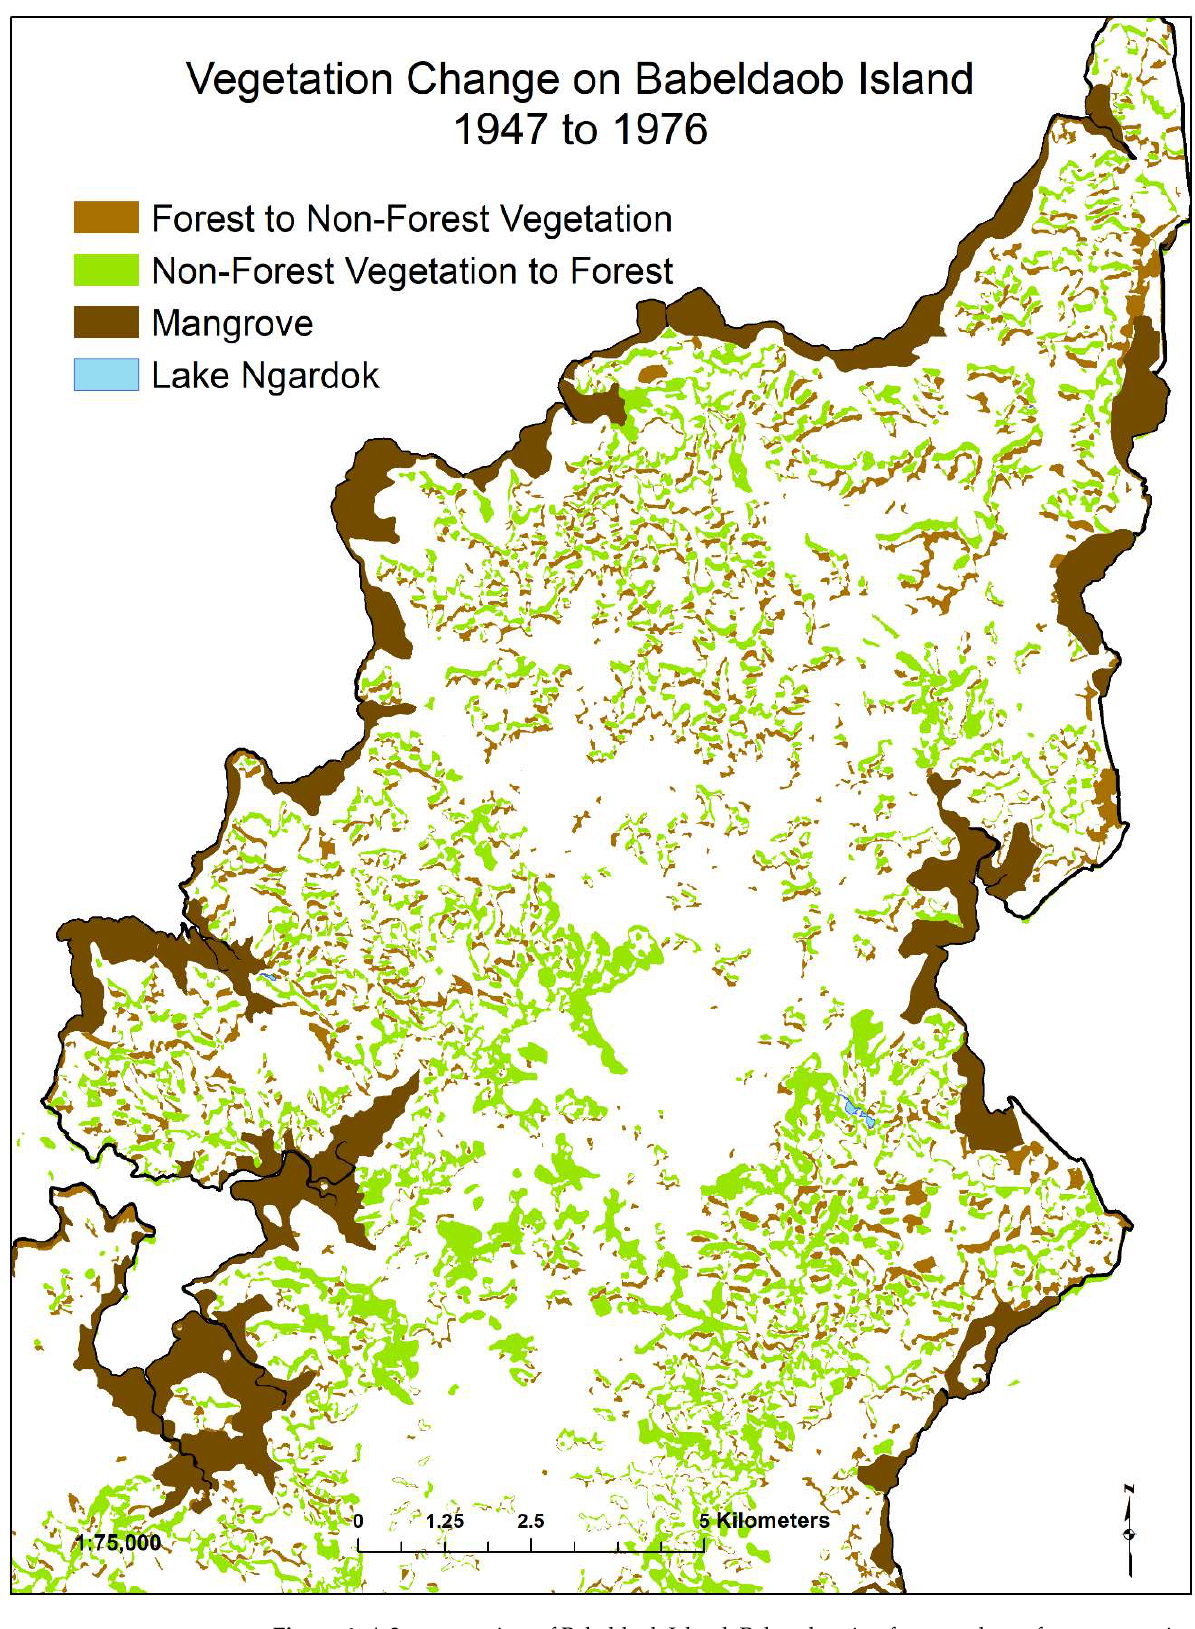
Figure 4. A 2× zoom view of Babeldaob Island, Palau showing forest and non-forest vegetation cover changes in the north central part of the island between 1947 and 1976.